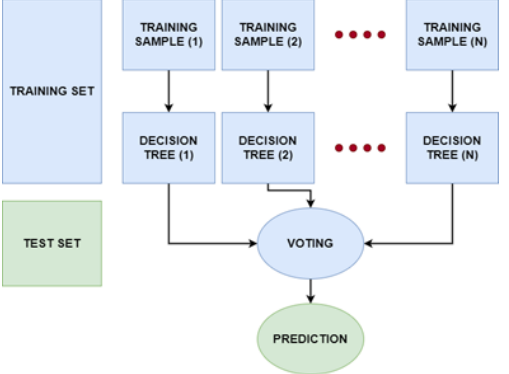
Figure 4. Conceptual diagram of the random forest model.